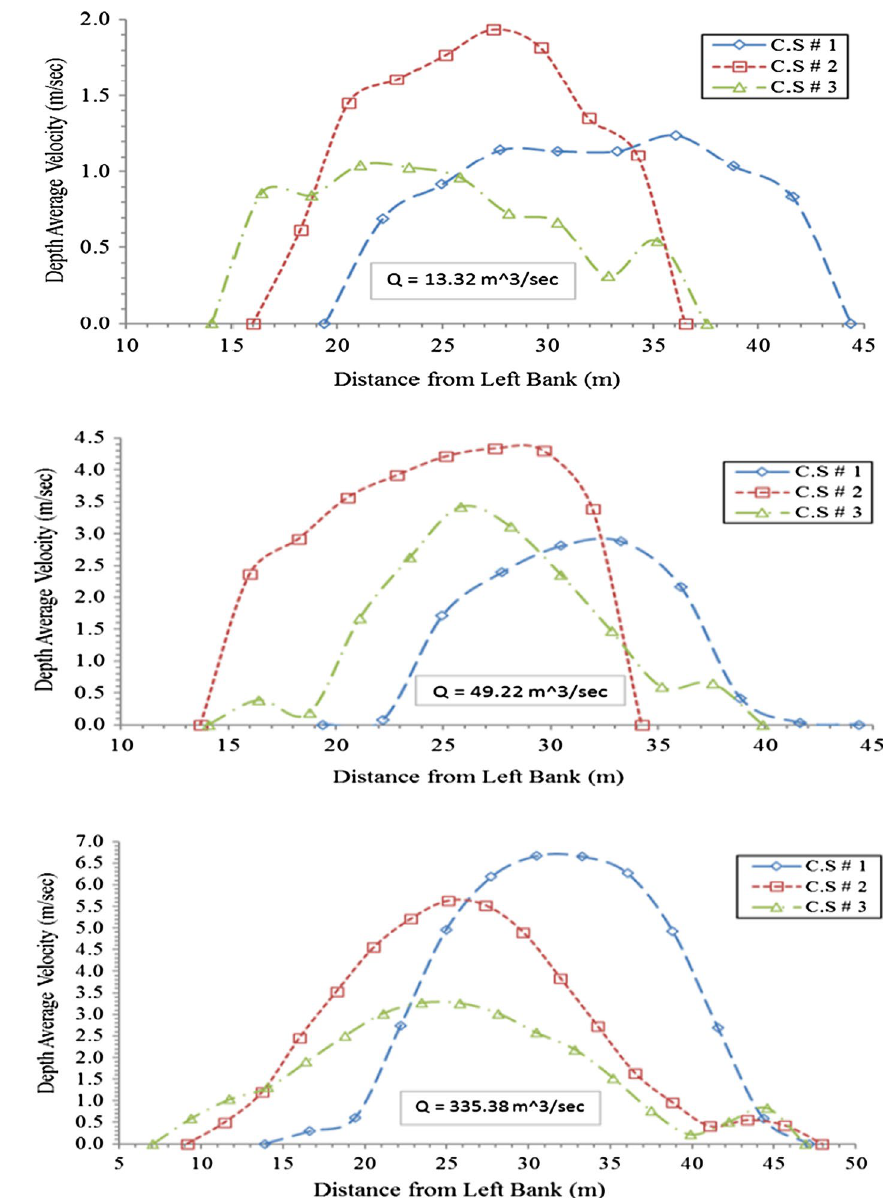
Fig. 10 Cross-profiles of depth average velocity in the straight